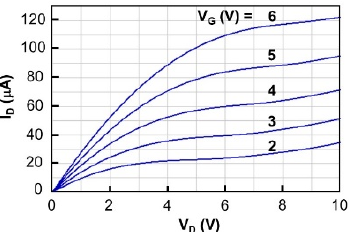
Figure 11. Drain current I D versus drain voltage V D characteristics as a function of the gate voltage V G . Parallel TFT. μ ‖ = 534 cm 2 /Vs.